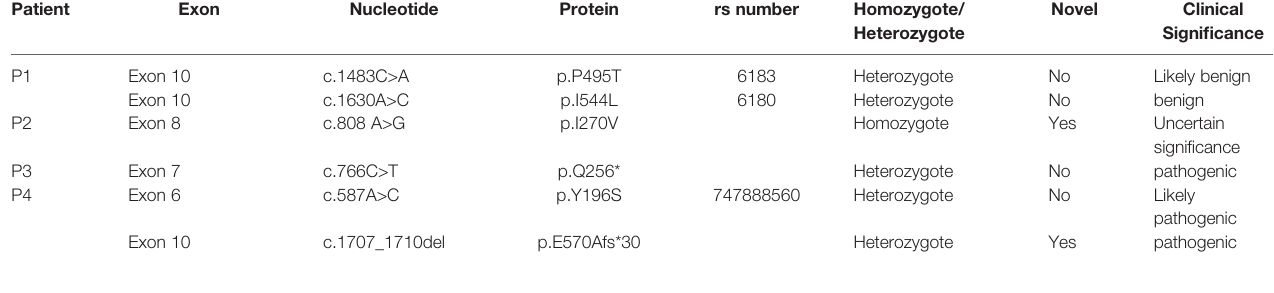
TABLE 3 | Genetic variants of the GHR gene in patients with Laron Syndrome.